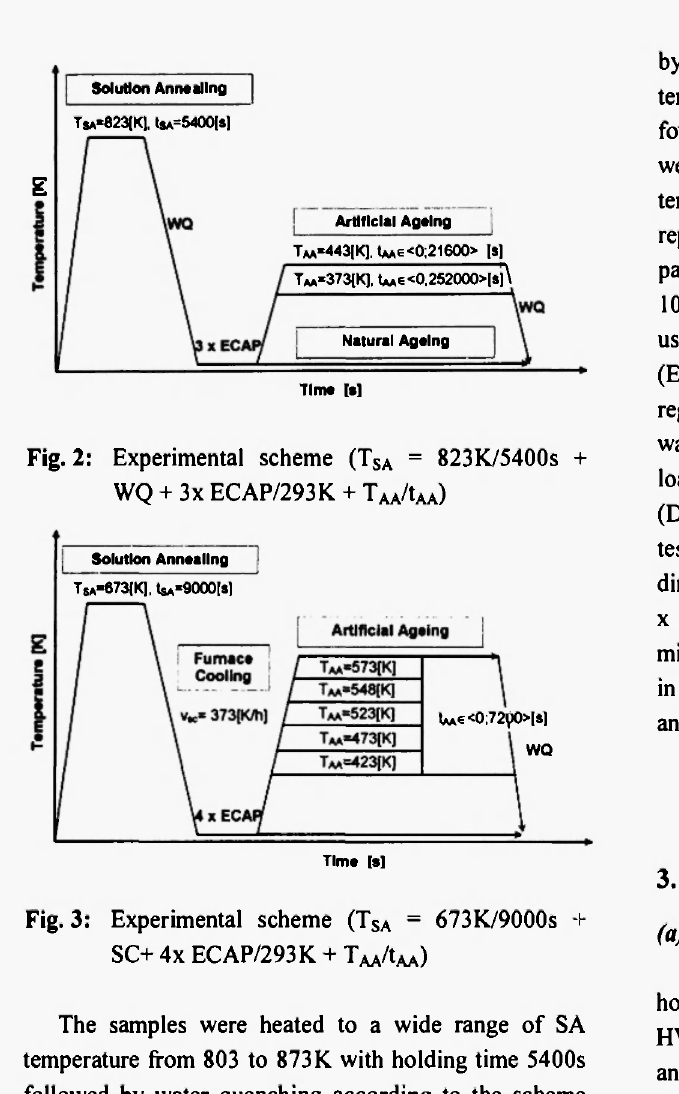
Fig. 3: Experimental scheme (T SA = 673K/9000s + SC+ 4x ECAP/293K + W t ^)